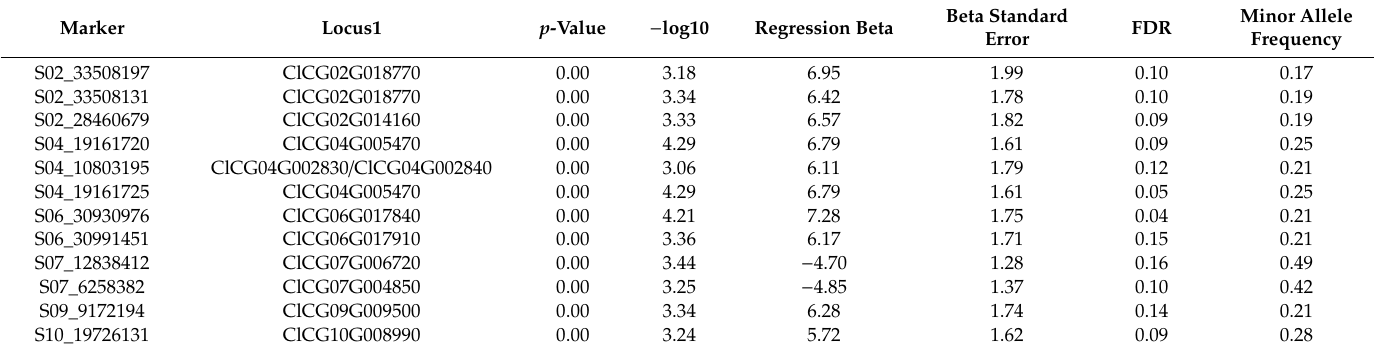
Table 1. The significant non-synonymous SNPs associated with citrulline content in watermelon flesh.